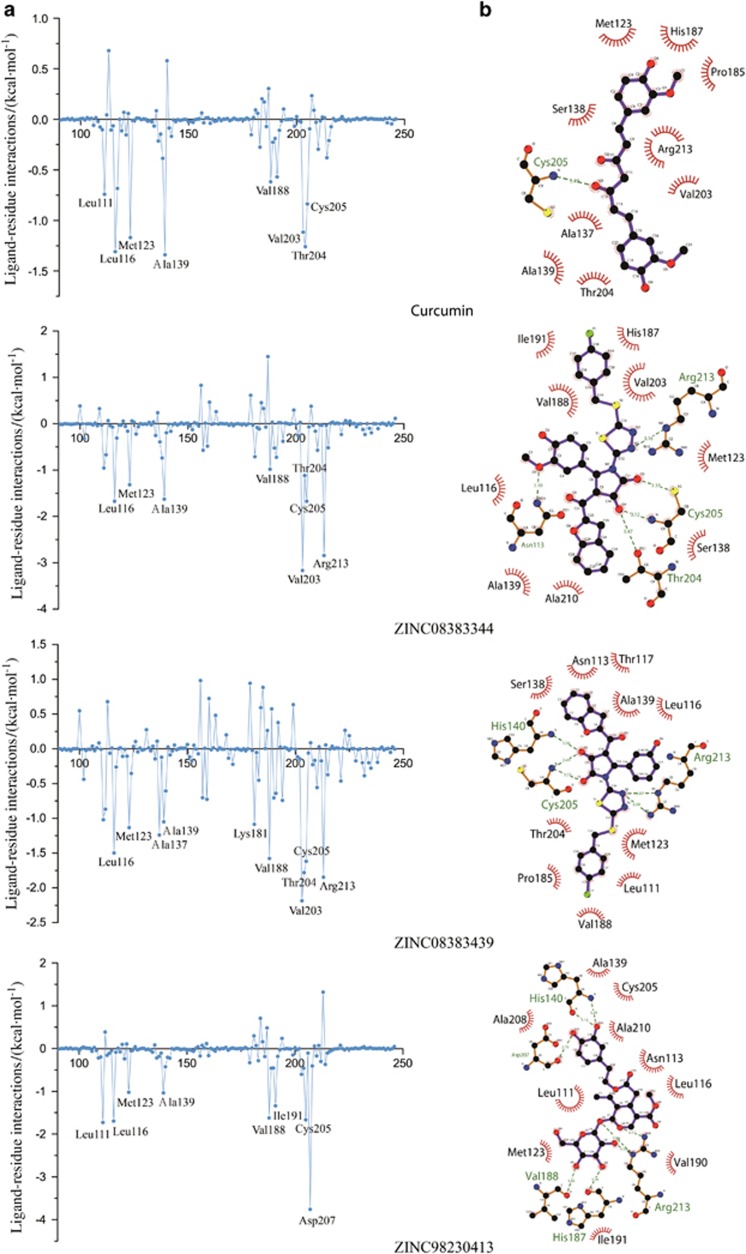
Binding free energy decomposition for per residue and interactions of each SrtA-compound complex in comparison with curcumin (ZINC08383458 and ZINC08441272 are listed in Supplementary Information). (a) Several crucial residue contributions of SrtA-compounds complexes. (b) Hydrogen bonds and hydrophobic interactions between SrtA and compounds. Hydrogen bonds and hydrophobic interactions are presented as green dotted line and red arcs, respectively. SrtA, sortase A.